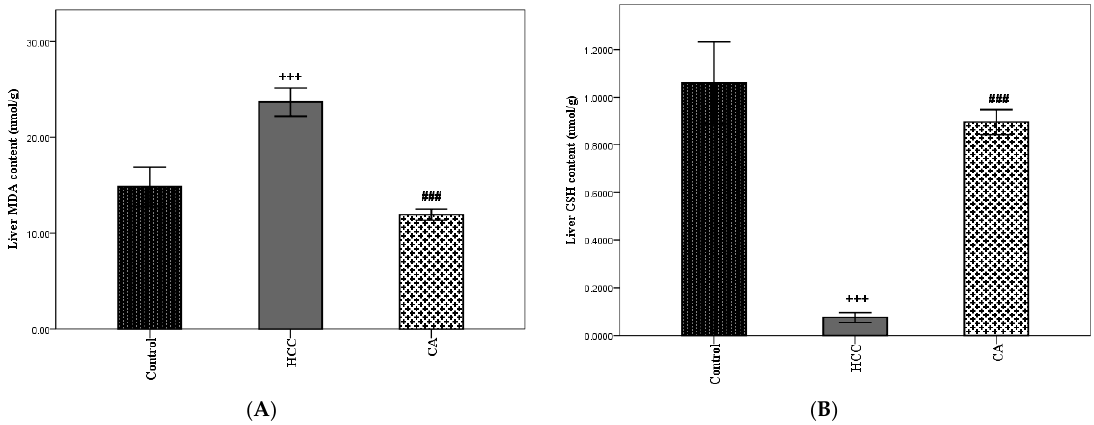
Figure 8. Effect of CA on TAA induced hepatic oxidative stress parameters. ( A ) Hepatic MDA con- tent and ( B ) Hepatic GSH content. Data were expressed as mean ± S.E.M. Ten rats in each group. +++ p < 0.001 vs. control group, ### p < 0.001 vs. HCC group.